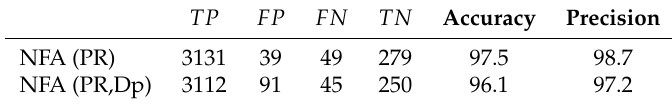
Table 4. Performance of Algorithm 1 for outlier detection among PR measurements or